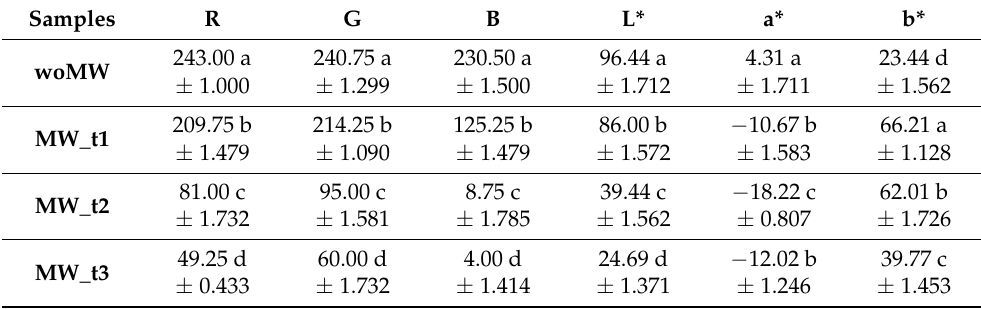
Table 4. Mean results of chromatic parameters of RGB and CIE L*, a*, b* spaces, from one-way ANOVA ( p = 0.05)